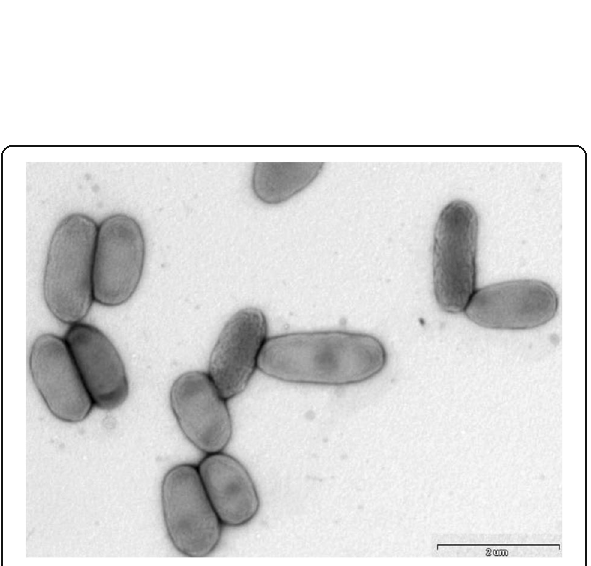
Fig. 2 Electron micrograph of negatively stained cells of Chryseobacterium bovis strain DSM 19482 T . Cells are nonflagellated rods. Bar, 2 μ